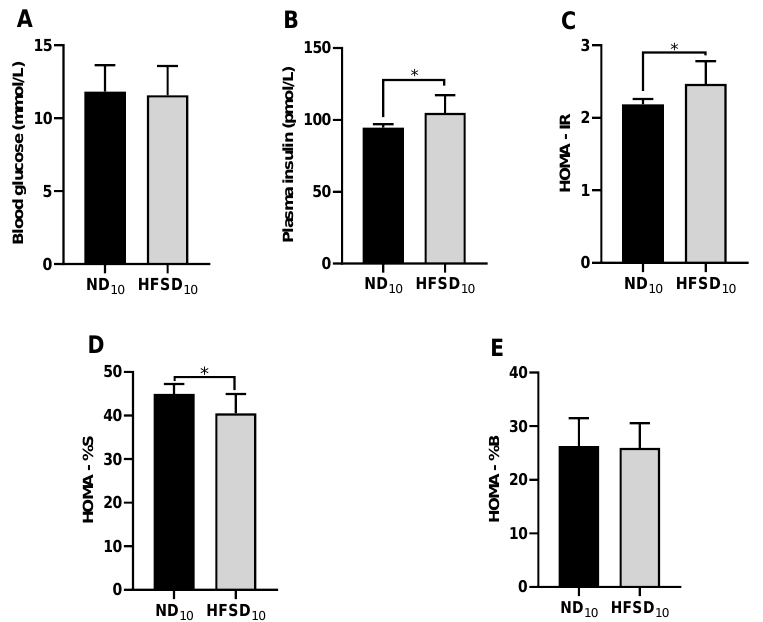
Figure 2. High-fat/sucrose diet feeding for 10 weeks causes dysregulated insulin metabolism. ( A ) Fasting blood glucose, ( B ) fasting plasma insulin, ( C ) insulin resistance, ( D ) insulin sensitivity, and ( E ) beta cell function in mice fed a normal diet or high-fat/sucrose diet for 10 weeks ( n ≥ 6 per group). Data expressed as means ± SD. ND 10 —10-week normal diet; HFSD 10 —10-week high-fat/sucrose diet; * p ≤ 0.05.